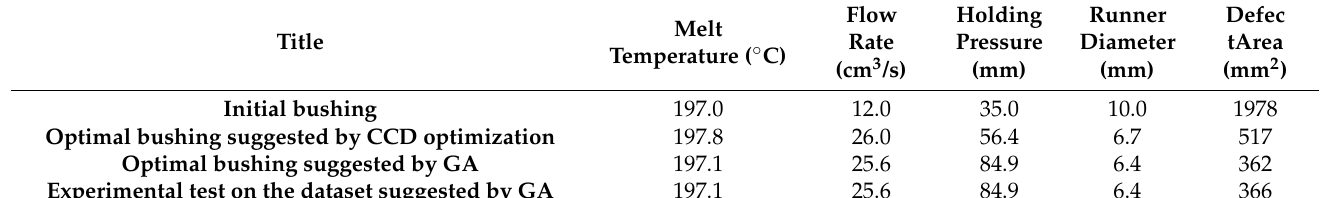
Figure 12. Optimization process by GA.